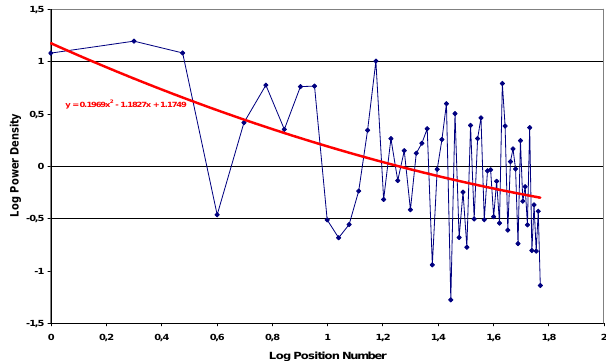
Fig. 25. Periodogram (black diamonds) of 118 zinc values with quadratic curve (red curve) fitted by least squares (Logarithms base 10). The flattening of the curve toward higher frequencies is due to the nugget effect (Logarithms base